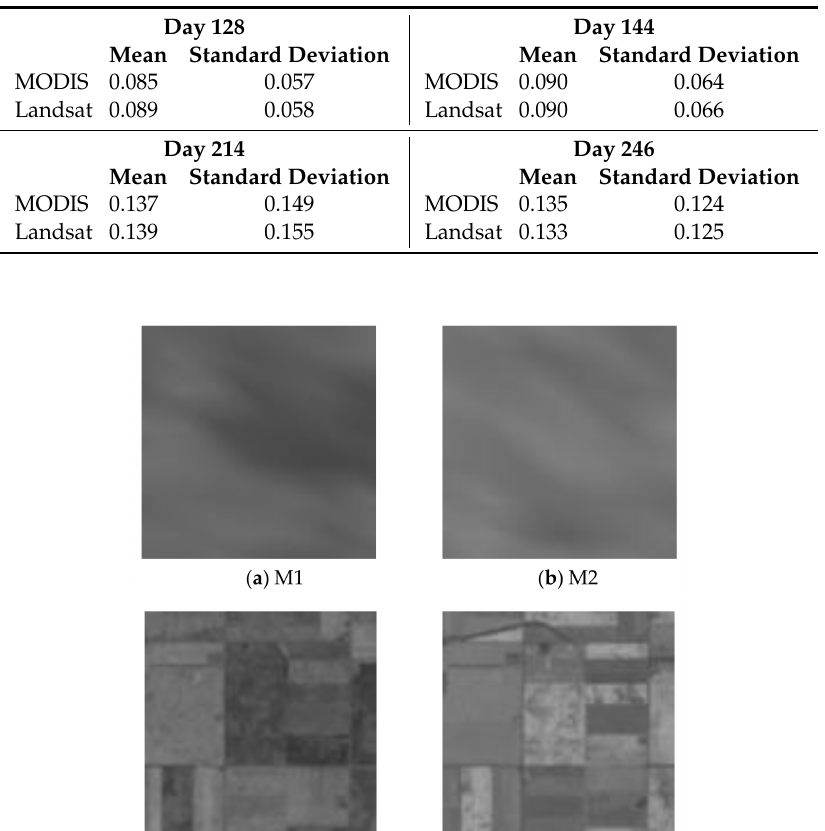
Table 1. Mean and standard deviation of MODIS and Landsat images at different dates.